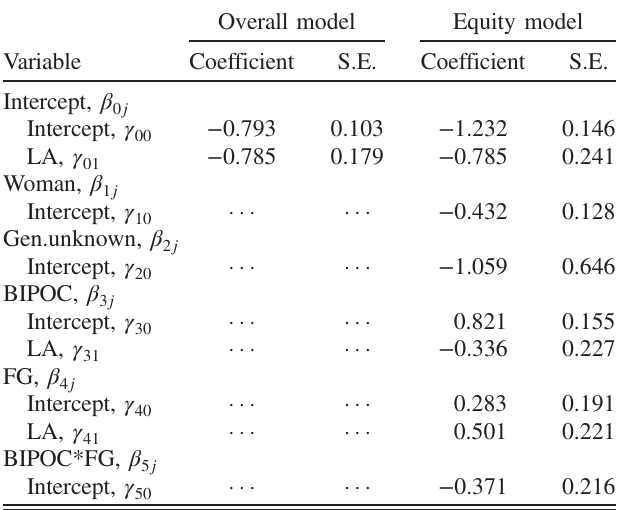
TABLE IV. Model for equity in DFW rates, accounting for instructor types.